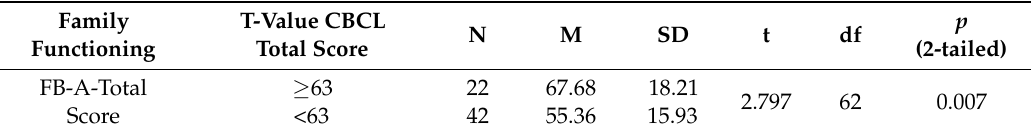
Table 4. T-Test for independent samples for children with vs. without psychological problems regarding family functioning of their families.